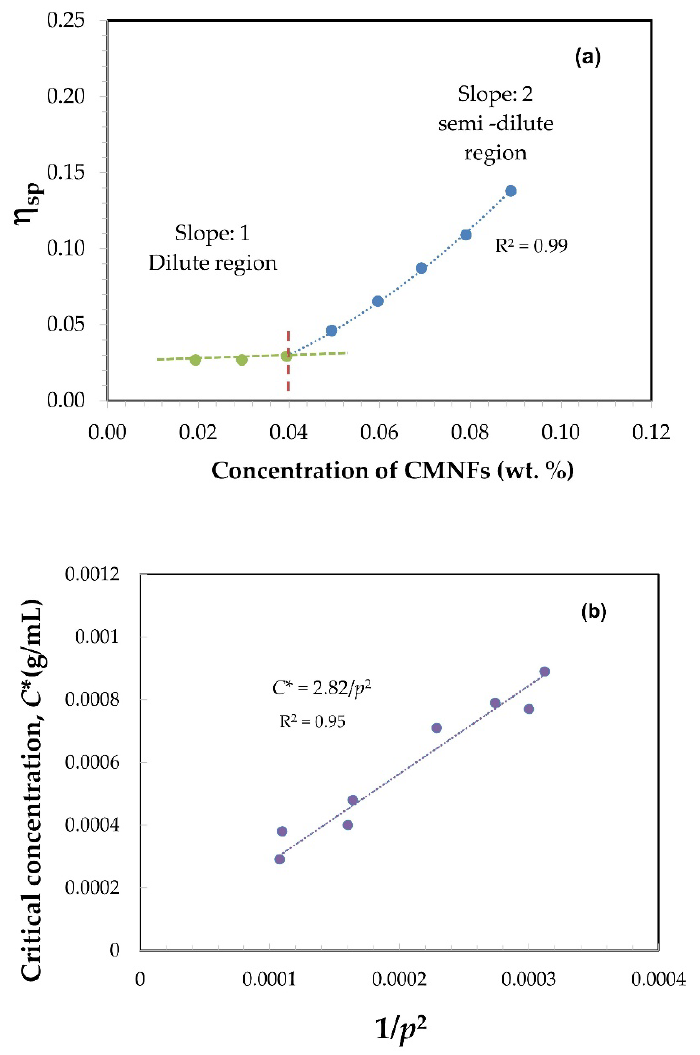
Figure 6. ( a ) Specific viscosity ( η sp ) as a function of the concentration for 25ox_Ut_5P CMNF; ( b ) critical concentration ( C* ) as a function of the inverse square of the aspect ratio (1/ p 2 ) for all CMNFs analyzed.